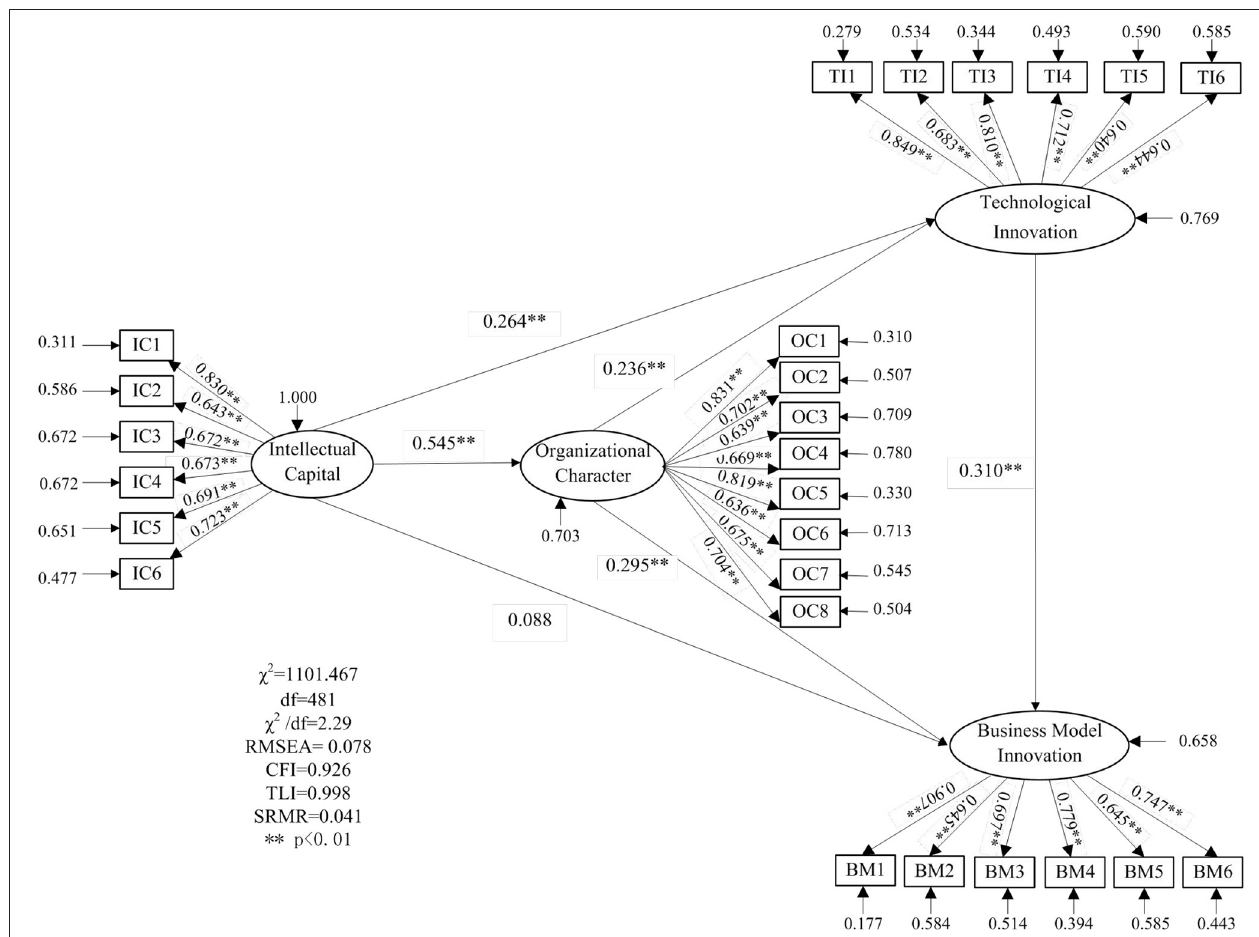
FIGURE 2 | Effect paths among the